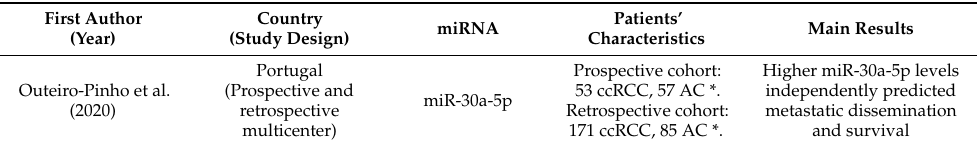
Table 3. Main characteristics of studies investigating the effects of urinary miRNAs in patients diagnosed with renal cell